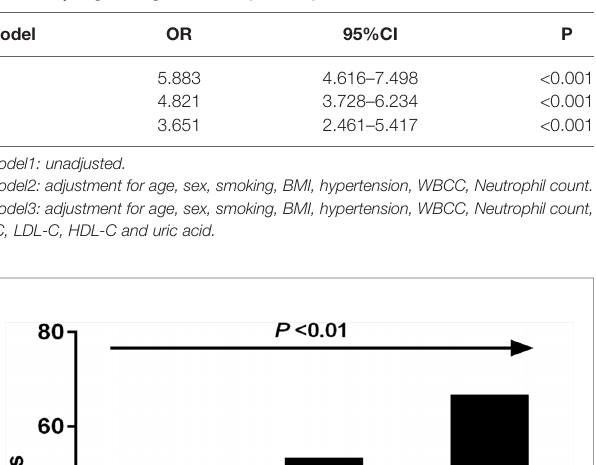
TABLE 2 | Logistic regression analysis of TyG index and NSCLC risk.